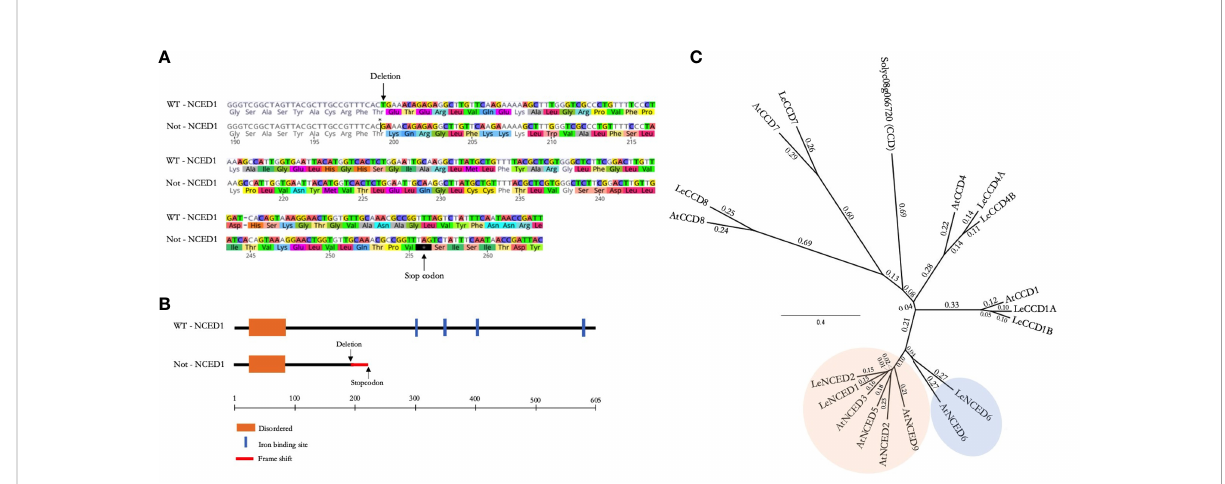
FIGURE 1 The NCED gene family and notabilis genotyping. (A) Protein sequence alignment of tomato NCED1 wild-type and notabilis , showing a single amino acid deletion (Thr199) and a premature stop codon. Arrows mark the deletion and early stop codon. (B) Schematic representation of the wild-type and notabilis (truncated) NCED1 protein, including functional domains. (C) Phylogenetic tree of the CCD and NCED proteins of tomato and Arabidopsis. The two NCED clusters are shown in orange and